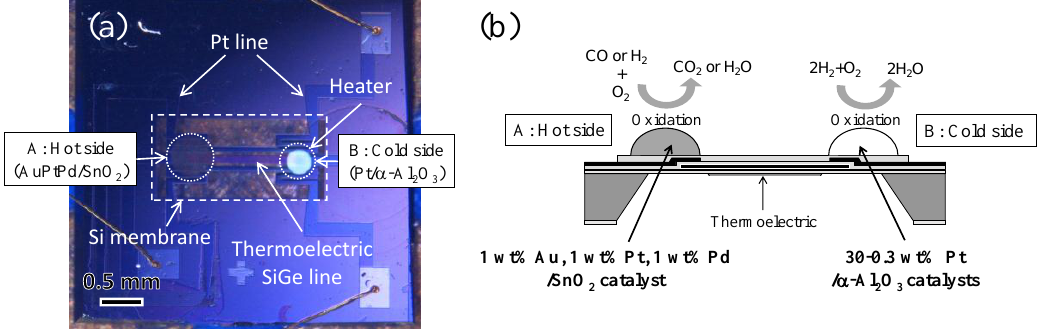
Figure 2. Optical images of the AuPtPd/SnO 2 and Pt/Al 2 O 3 catalysts on the Si membrane of the micro-TGS ( a ), and a side view of the double catalyst structure ( b ).